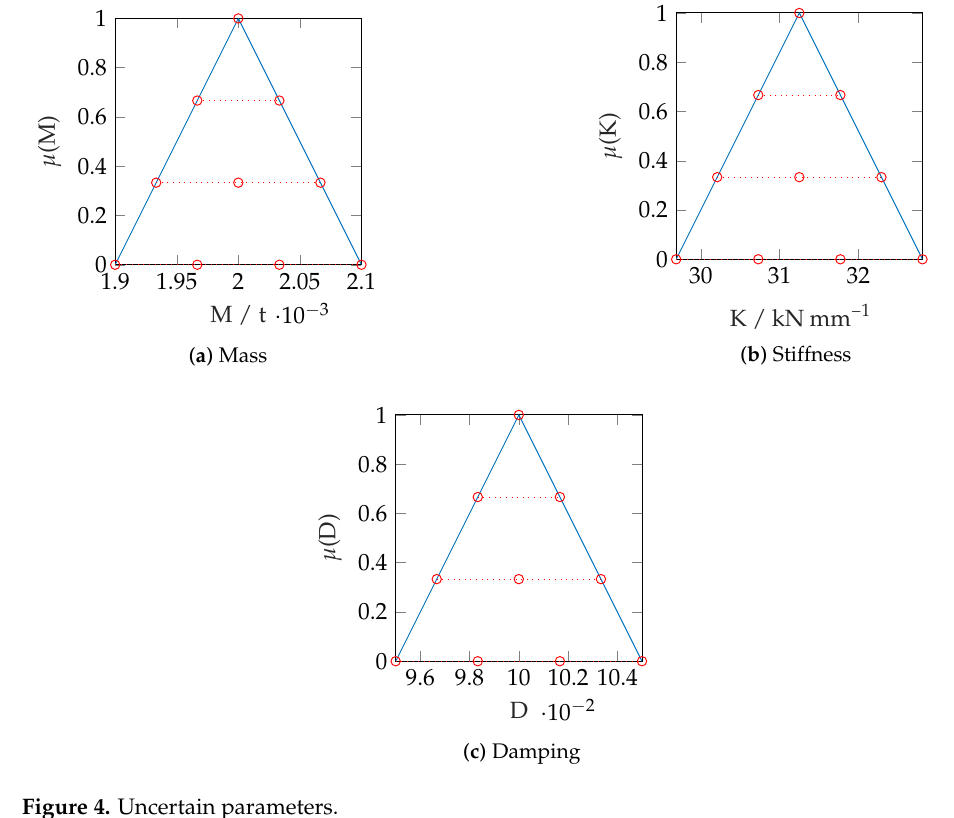
Figure 4. Uncertain